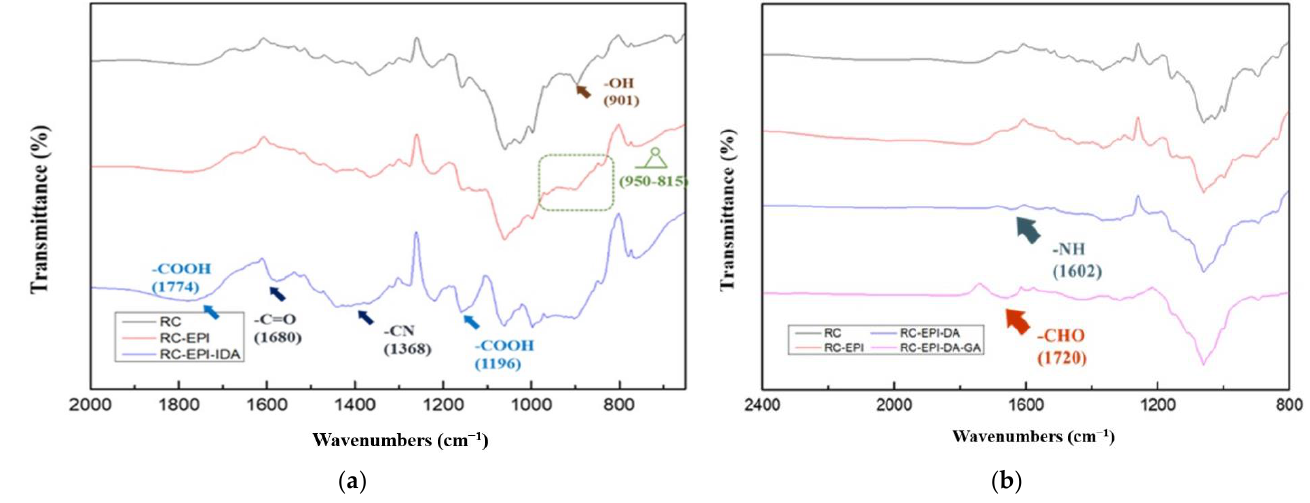
Figure 3. FTIR characterization of ( a ) RC-EPI-IDA membrane and ( b ) RC-EPI-DA-GA membrane.